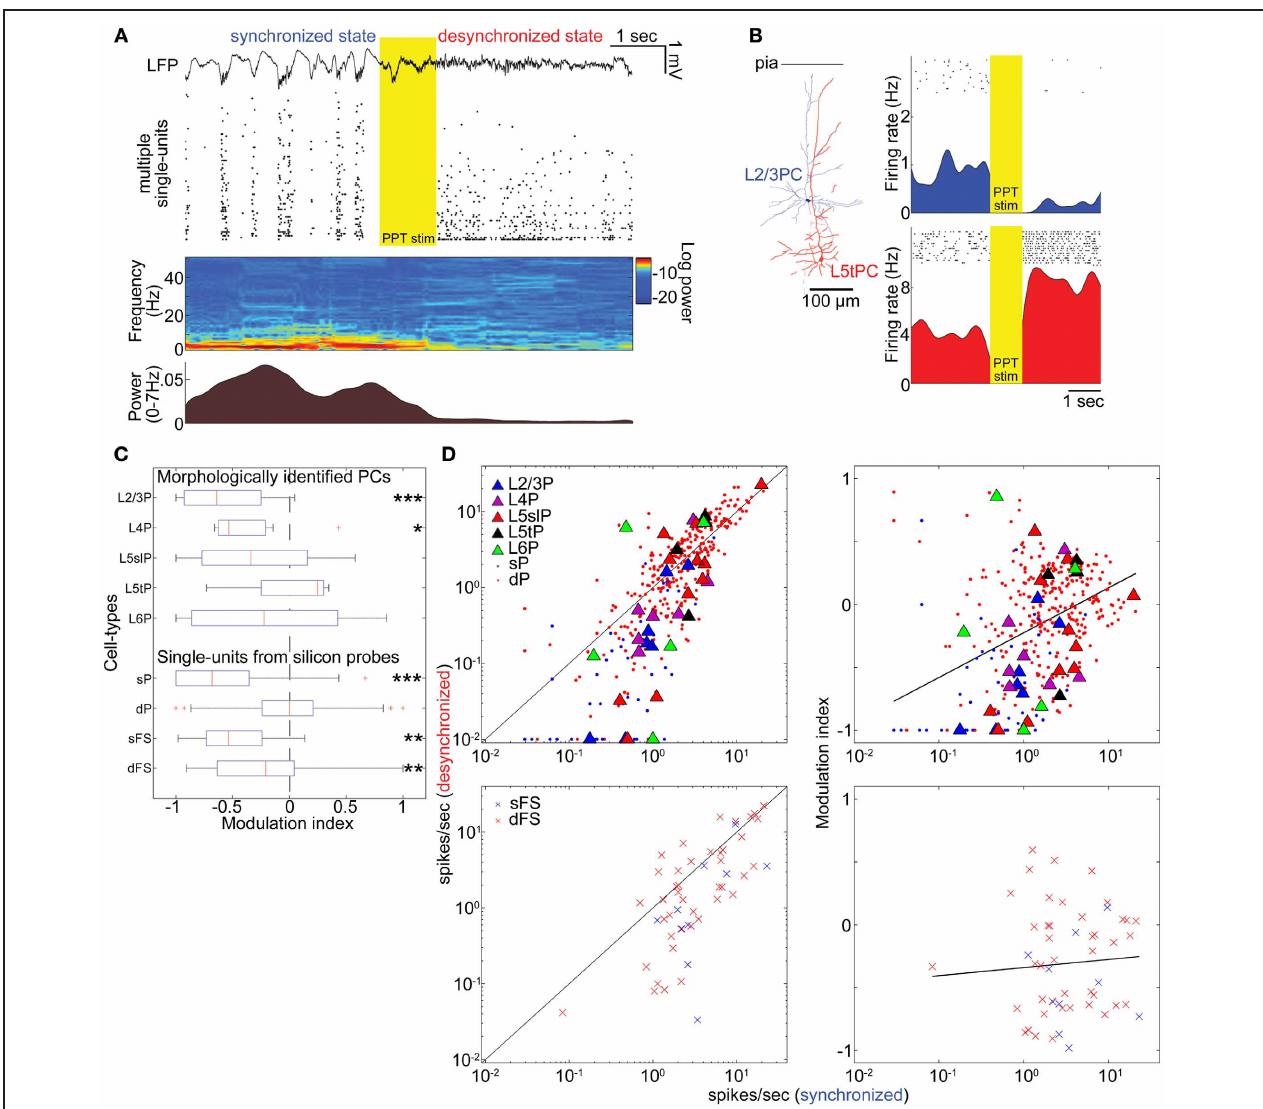
FIGURE 2 | State-dependent and cell-type-specific spontaneous firing. (A) An example of pedunculopontine tegmental (PPT) nucleus stimulation and neural population activity in the auditory cortex. LFP, multiple single-units, spectrogram, and a history of low-frequency LFP power are shown. (B) Examples of morphologically identified pyramidal cells (PCs) and the effects of PPT stimulation on their spiking. Rasters show response of these cells to repeated PPT stimuli; lower graphs show peri-stimulus time histograms. (C) Modulation index of morphologically identified PCs and extracellularly classified single-units. L5slP, L5 slender PCs; L5tP, L5 thick